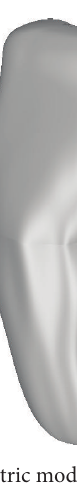
Figure 2: Parametric model of a maxillary incisor.